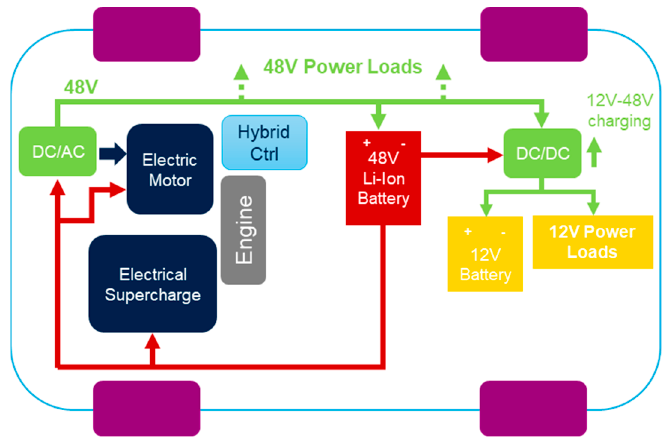
Figure 3. Mild hybrid block diagram.